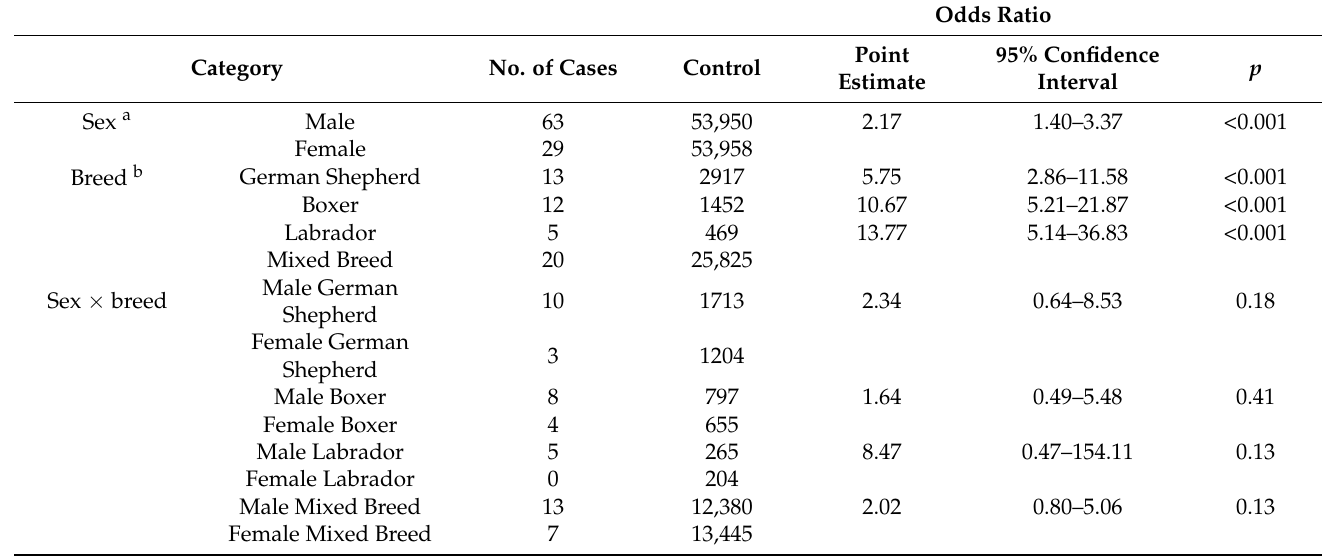
Table 1. Crude odds ratio (OR) of IRE development by sex and breed.